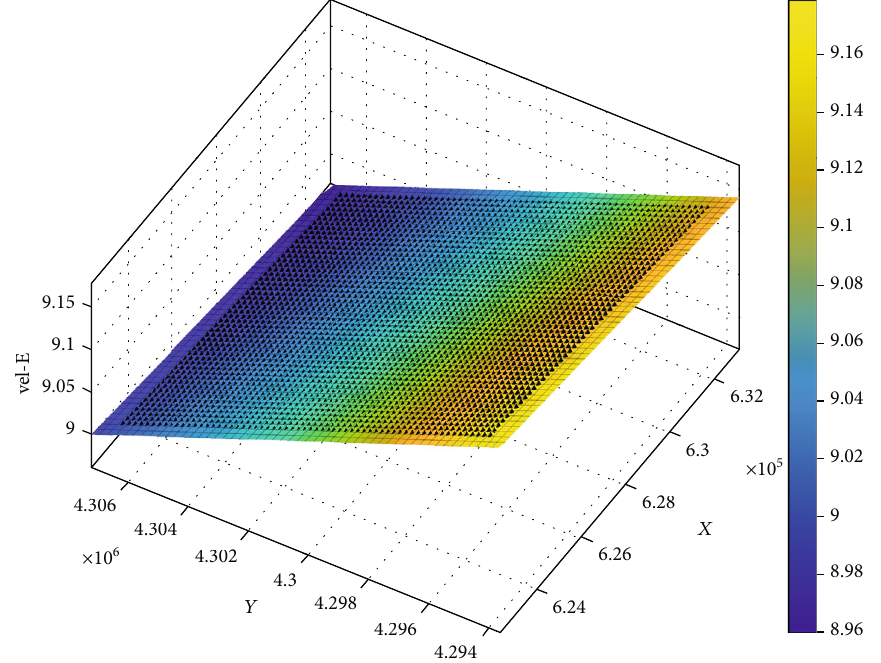
Figure 11: Fitting of the eastward velocity isoline